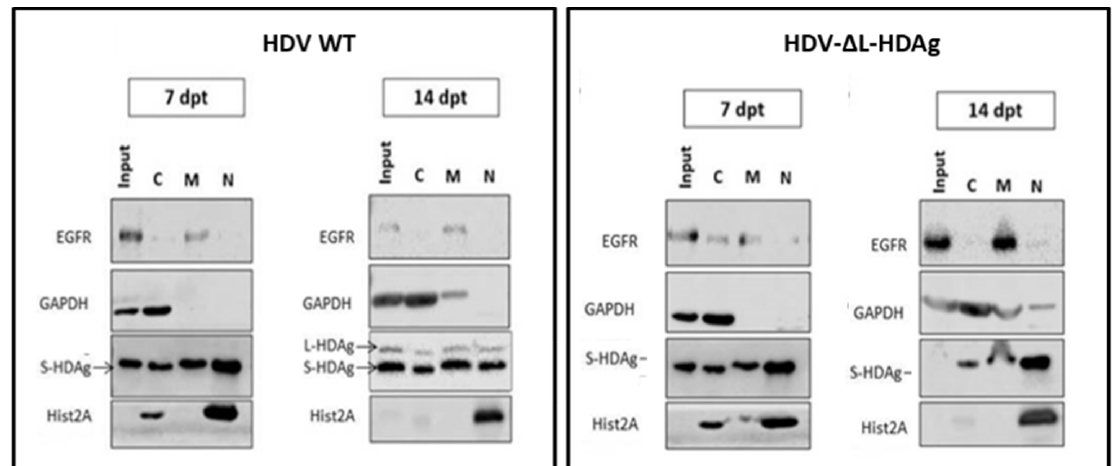
Figure A2. Huh-7 cells were transfected with HDV WT or HDV- ∆ L-HDAg plasmid and they were harvested at 7 and 14 dpt. Cellular extracts were fractionated to determine the subcellular localization of S-HDAg and L-HDAg. The purity of each subcellular fractions was determined by analysing the expression of GAPDH (control of cytosolic-enriched fraction), EGFR (control of membrane fraction), and Histone2A (control of nuclear-enriched fraction).